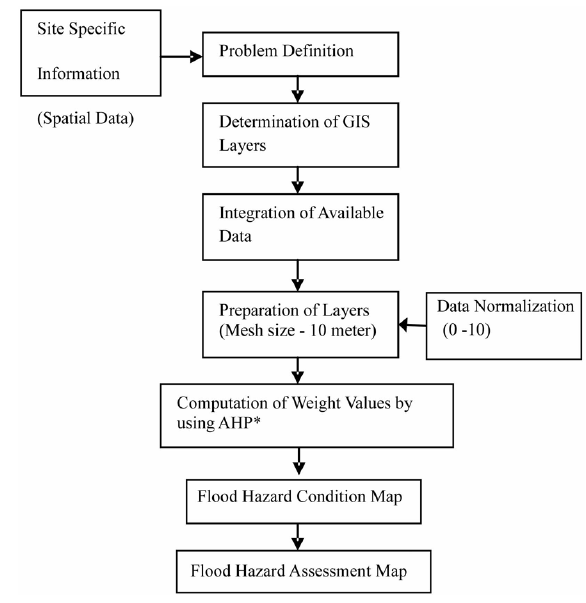
Figure 2. Flow chart for making the flood hazard map. ∗ AHP – Analytical Hierarchy